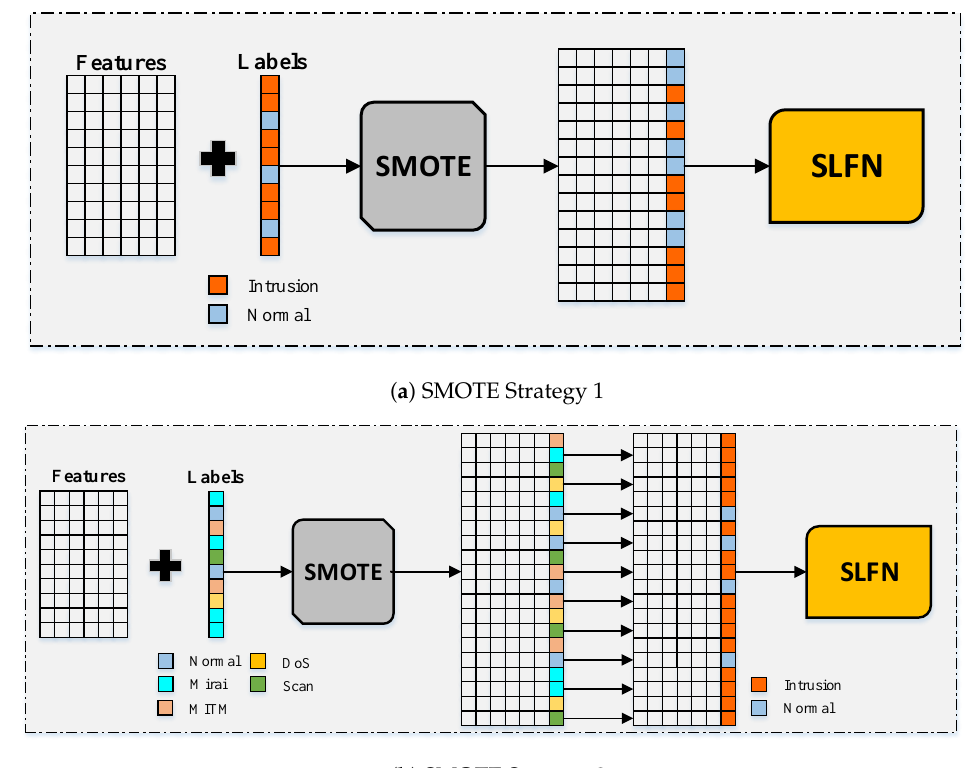
Figure 5. Adopted oversampling strategies in the first stage of the proposed